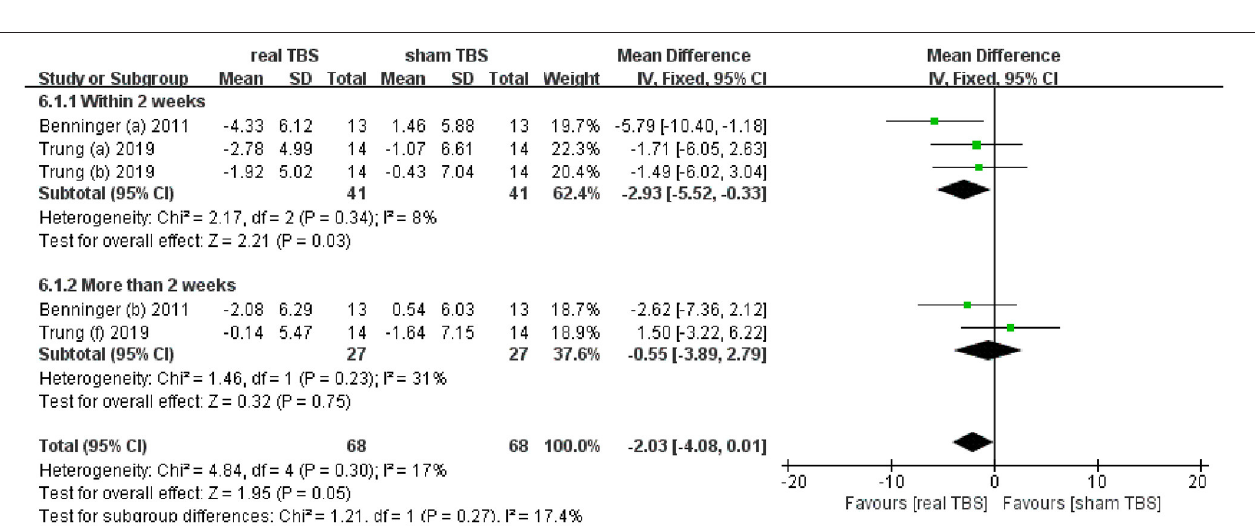
FIGURE 5 | Forest plot and metaanalysis of depression between real TBS and sham TBS: subgroup analysis based on different follow-up times.